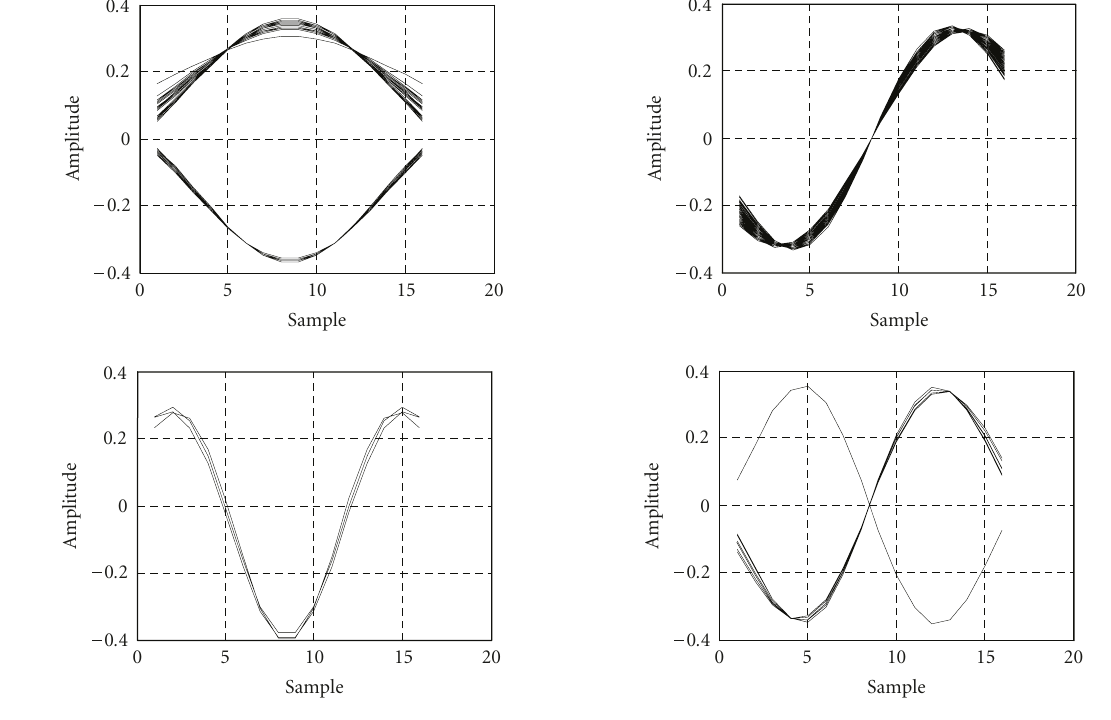
Figure 1: Some selected eigenvectors which exhibit similar patterns for L F =